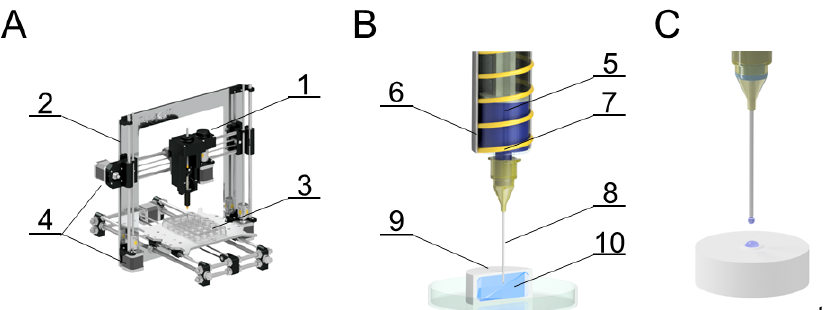
Figure 4. Overall diagram of the bioprinter ( A ); printhead diagram ( B ); printhead detail ( C ). ( A )